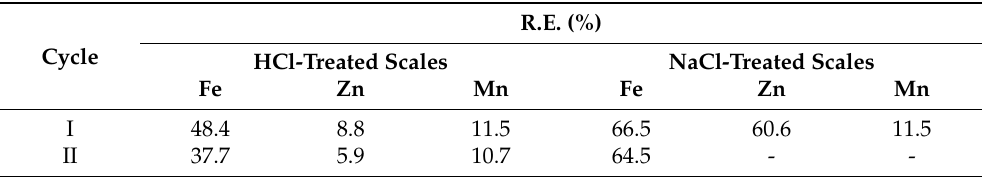
Table 6. The effect of adsorption–desorption cycle on the efficiency of the recycled fish scales to remove the metal ions from AMD. R.E. (%) Cycle HCl-Treated Scales NaCl-Treated Scales Fe Zn Mn Fe